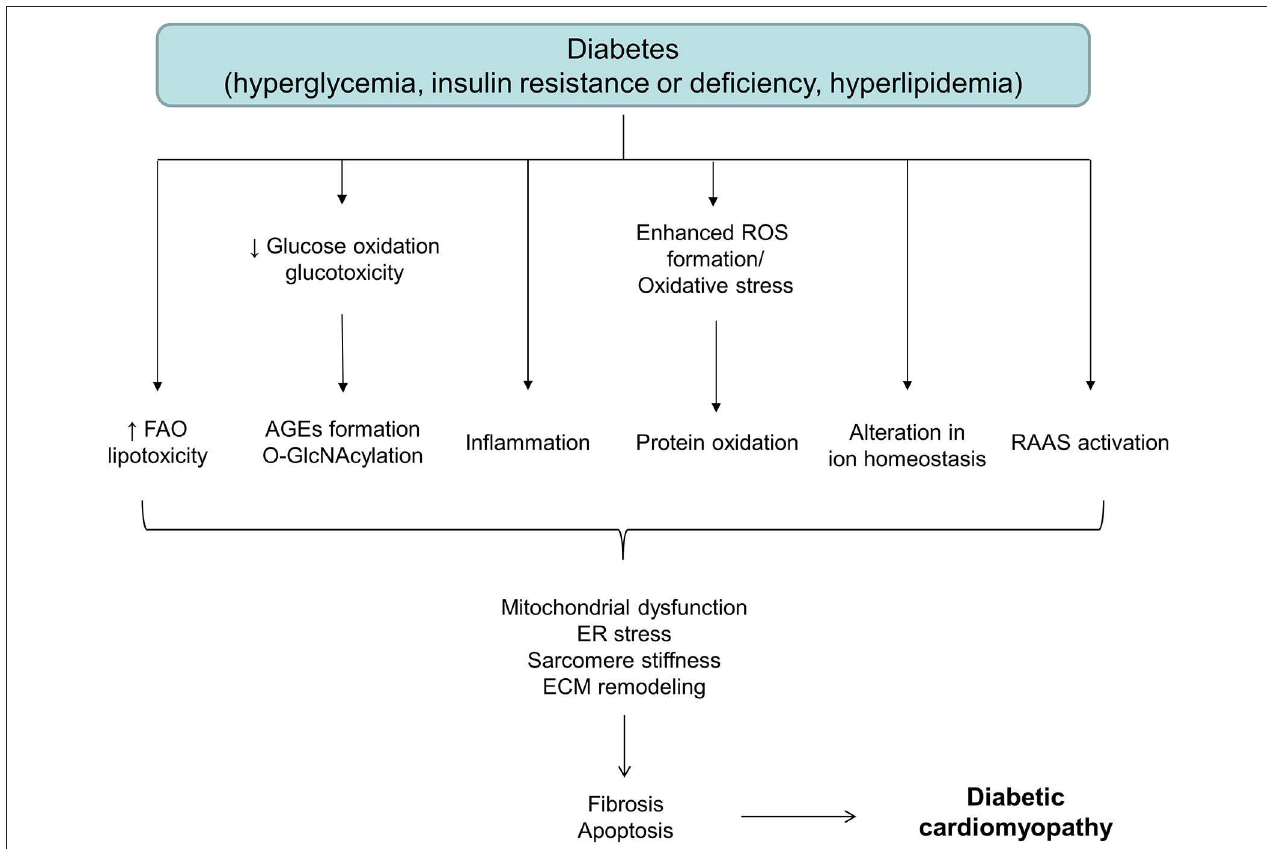
FIGURE 1 | A schematic diagram depicting different factors involved in the onset and development of diabetic cardiomyopathy. AGEs, advanced glycation end products; ECM, extracellular matrix; ER, endoplasmic reticulum; FAO, fatty acid oxidation; RAAS, renin-angiotensin-aldosterone system; ROS, reactive oxygen